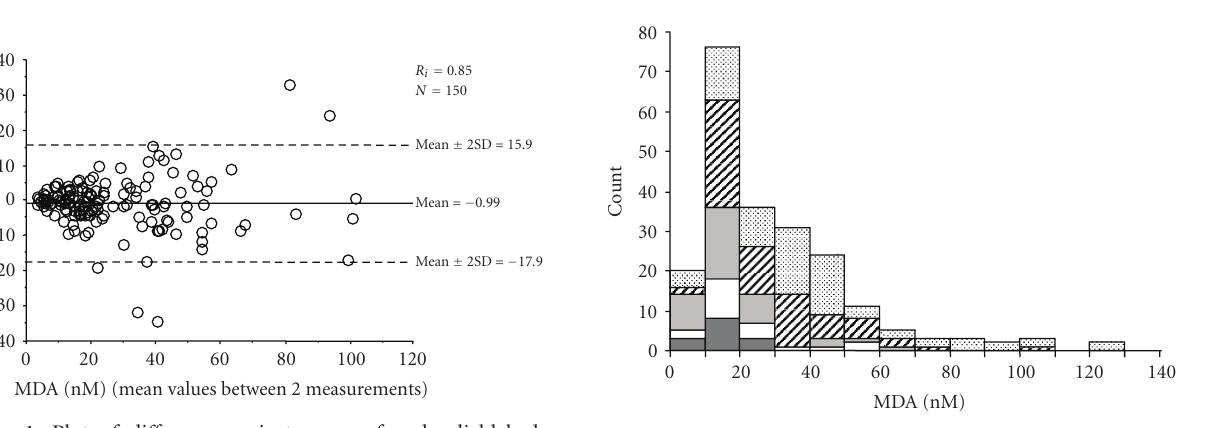
Figure 1: Plot of di ff erence against mean of malondialdehyde (MDA) values obtained from two subsequent analyses. R i : intraclass correlation coe ffi cient.